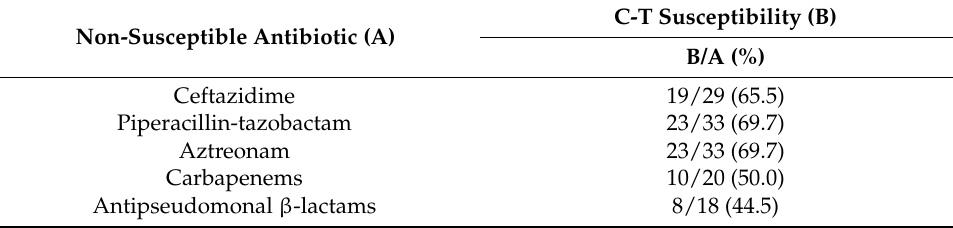
Table 5. The susceptibility of ceftolozane-tazobactam for isolates non-susceptible to various antibiotics.